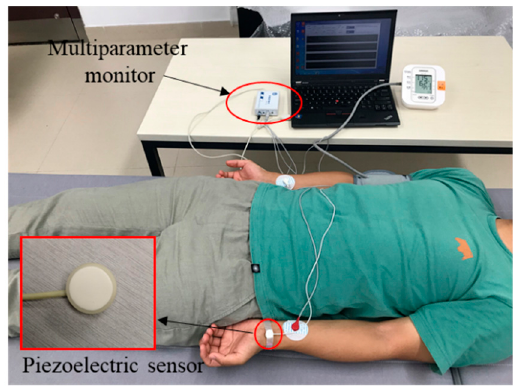
Figure 2. Experimental scenario.